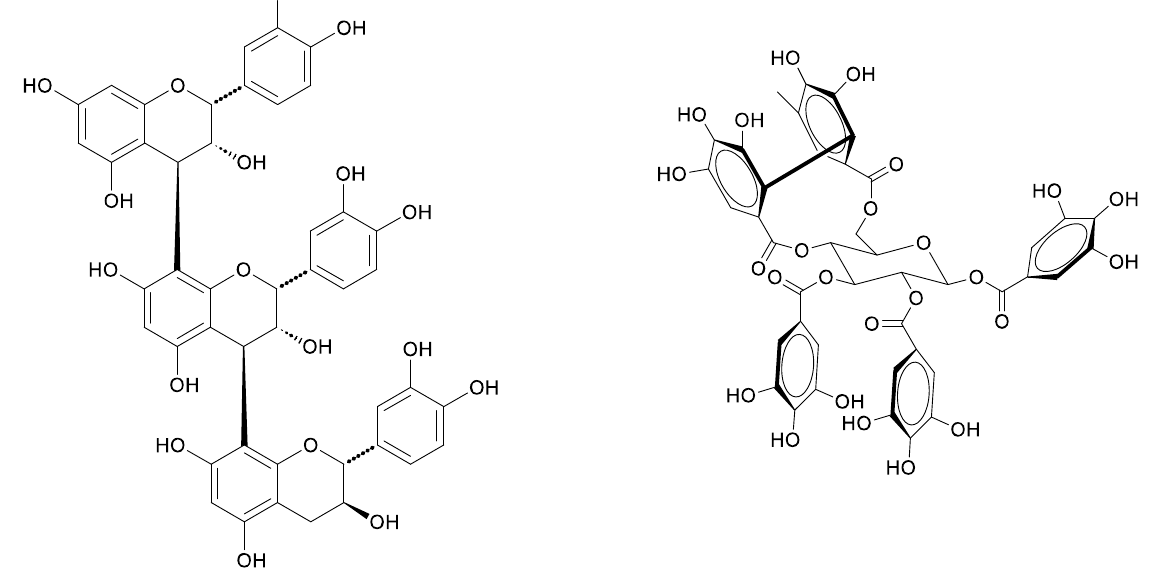
Figure 3. Representative chemical structures of condensed ( left ) and hydrolyzable ( right ) tannins. CTs (proanthocyanidins), which are more common than HTs in plants and are found in higher concentrations, consist of polymerized flavan-3-ol monomers and vary in location and number of hydroxyl groups and stereochemistry [87,88]. They are widely distributed in different leguminous types of forage such as birdsfoot trefoil ( Lotus corniculatus L.), sainfoin ( Onobrychis viciifolia Scop.), and sericea lespedeza ( Lespedeza cuneate (Dum. Cours.) G. Don) [89]. Less-utilized. types of leguminous forage containing CTs include Illinois bundleflower ( Desmanthus illinoensis ), big trefoil ( Lotus pedunctulatus ), panicled leaf ticktre- foil ( Desmodium paniculatum ), sunshine mimosa ( Mimosa stringillosa ), purple prairie